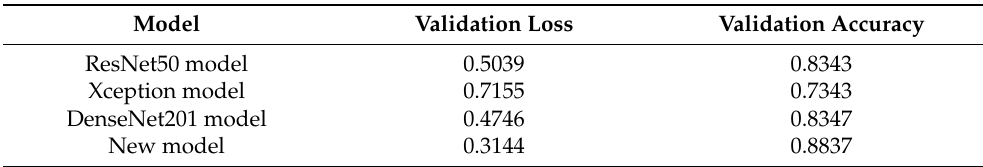
Table 5. Validation accuracy and the validation loss of noisy Intel image classification dataset performed with four different classification models.